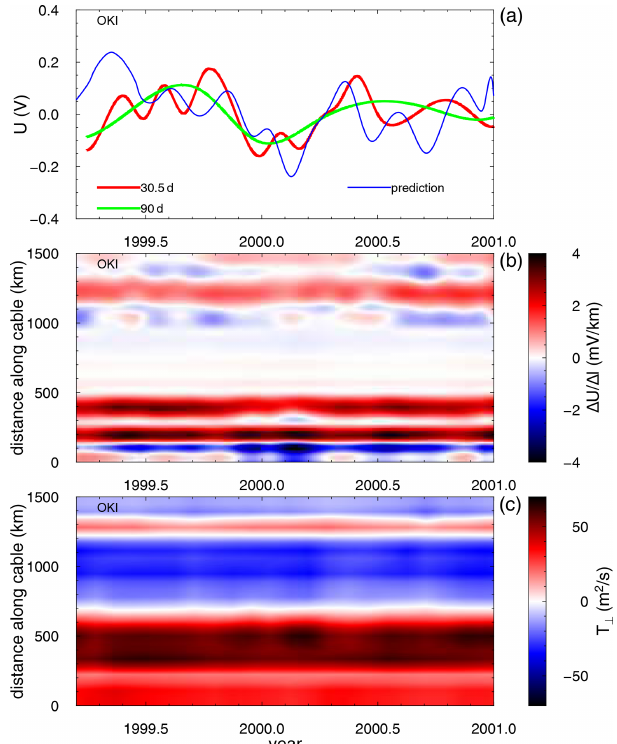
Figure 5. The results for the HAW1 cables. The HAW1N and HAW1S cables are distinguished by the solid and dashed lines in panel (a) . The cable orientation is from California to Hawaii. Oth- erwise, the description corresponds to Fig.